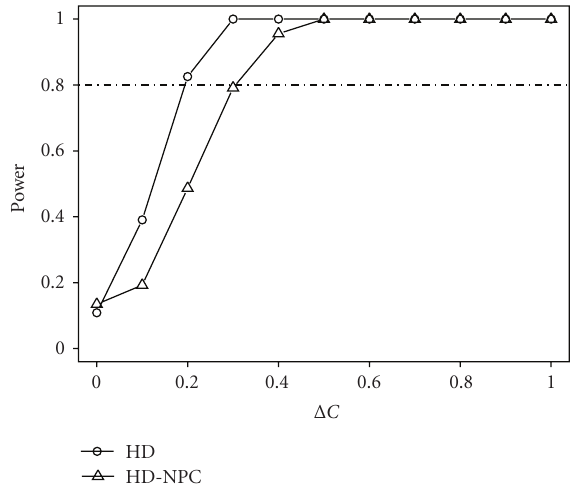
Figure 5: Power of HD and HD-NPC to detect mating asymmetry. Power is shown as a function of departure from mating symmetry, as measured by Δ C , under the null model where GC 11 = GC 12 = GC 22 = GM 11 = GM 12 = GM 22 = 1 (Table 2, Model 5). Allele prevalence is set at q = 0 . 3. Mating asymmetry was evaluated in the log-linear framework using a 3 degree-of-freedom likelihood-ratio test comparing the 9 mating-type parameter model under MA to a 6 mating-type parameter model under MS. Horizontal reference line indicates power = 0.8. HD: hybrid design using parents of controls in a log-linear framework; HD-NPC: log-linear analysis using unrelated controls rather than their